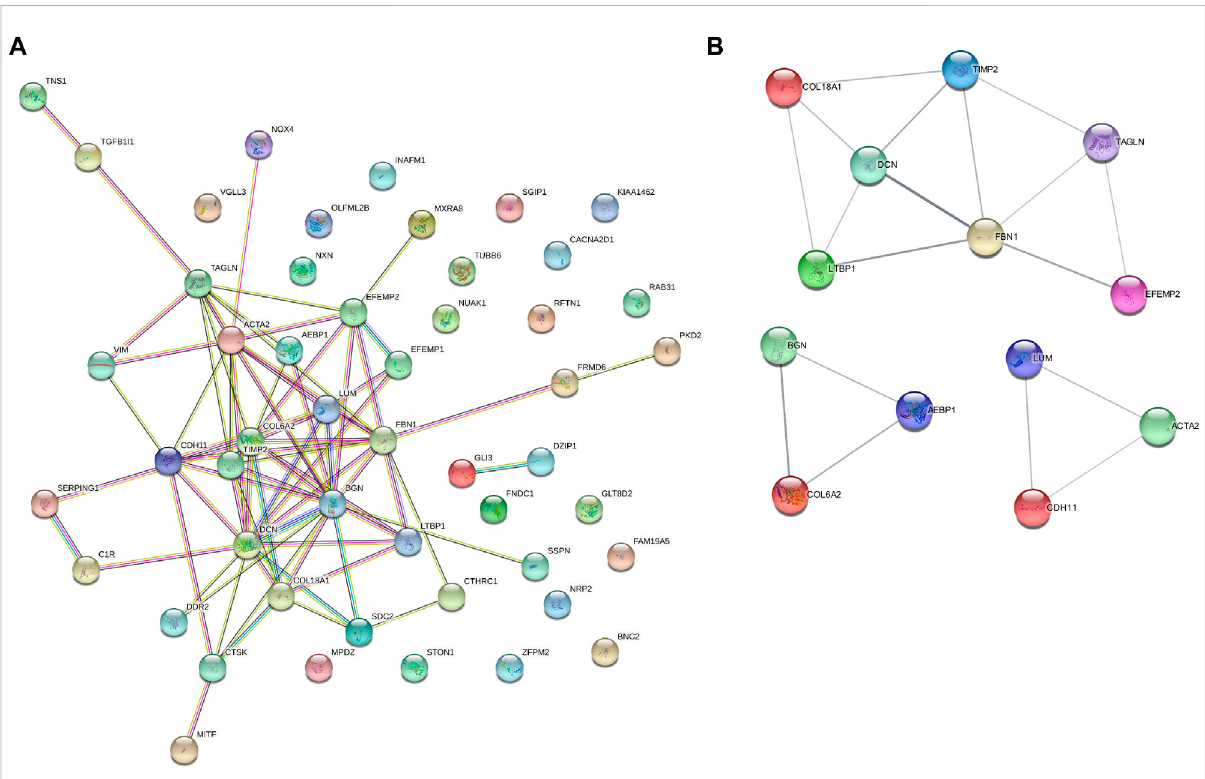
FIGURE 9 Protein – proteininteraction(PPI)analysisof50hubgenesandkeynodegeneidenti fi cation. (A) PPIanalysisbasedonSTRING. (B) Keynodegene identi fi